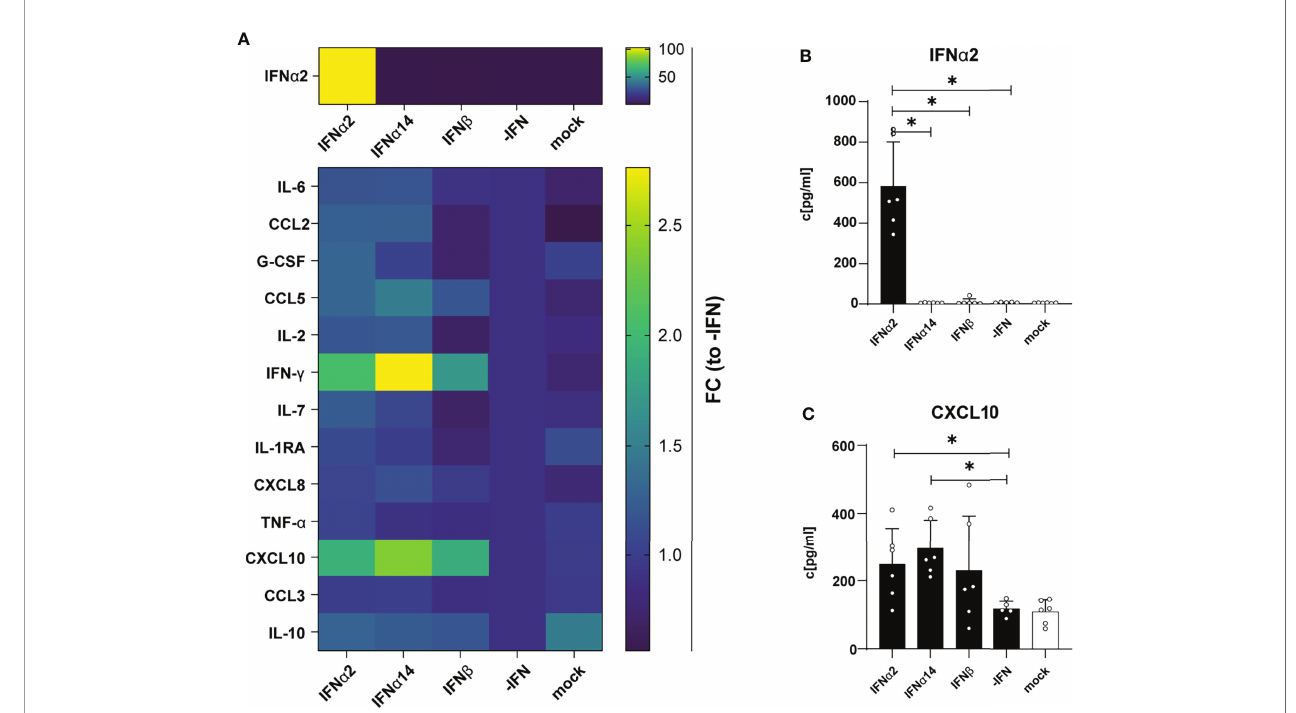
FIGURE 2 | Cytokine and chemokine pro fi le in supernatants from HIV- and mock-infected LPMCs after different IFN treatment. LPMCs were infected with X4-HIV- 1 NL4-3-IRES-Ren or mock treated with medium and treated with 2000 U/ml IFN a 2, IFN a 14, IFN b , or without IFN (-IFN). Supernatants were harvested 4 dpi and 14 cytokines and chemokines were analyzed simultaneously by a multiplex bead-based assay. (A) Averaged fold changes (FC) of each individual donor of IFN a 2, IL-6, CCL2, G-CSF, CCL5, IL-2, IFN g , IL-7, IL-1RA, CXCL8, TNF a , CXCL10, CCL3, and IL-10 expression of HIV-infected LPMCs after stimulation with type I IFN subtypes relative to HIV-infected, non-treated LPMCs (-IFN). (B, C) Absolute quanti fi cation of IFN a 2, and CXCL10 in supernatants of HIV-infected LPMCs treated with IFN a 2, IFN a 14, IFN b , or without IFN (-IFN). Mean values ± SEM are shown for n=6. Statistical analyses between the treated groups within a cell population were performed by using Friedman test and Dunn ’ s multiple comparison test. *, P <